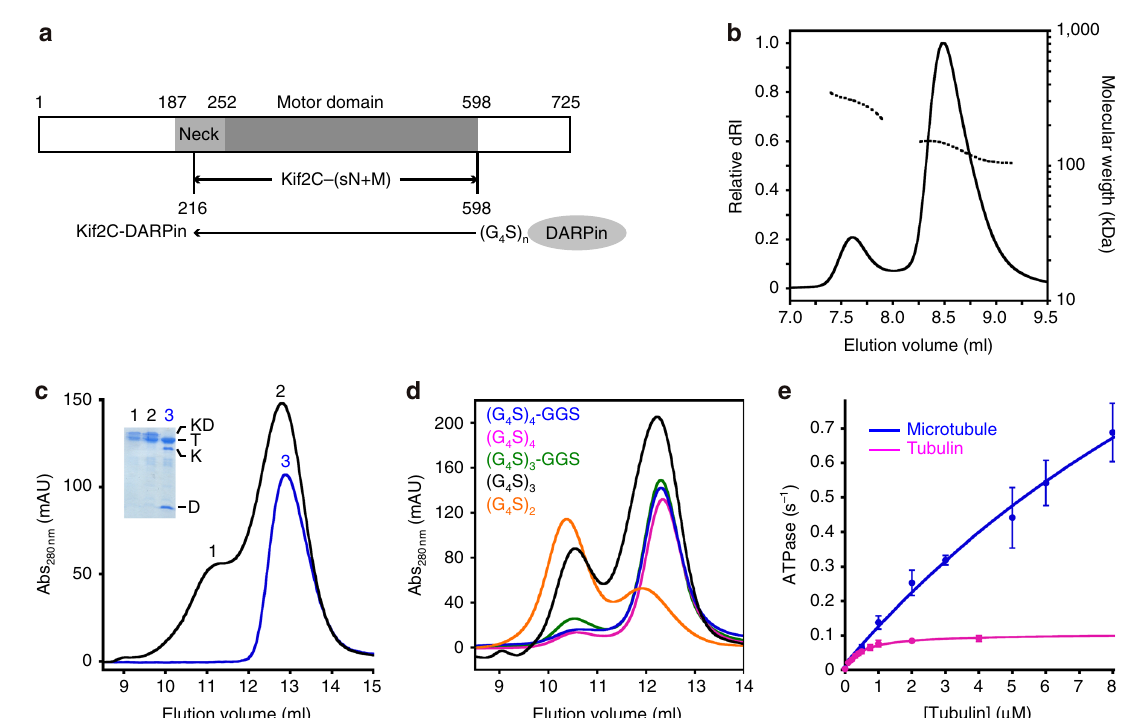
Fig. 1 Characterization of Kif2C-DARPin constructs. a Schematic presentation of Kif2C, of Kif2C-(sN+M), and of Kif2C-DARPin chimerical constructs. b SEC-MALLS analysis of tubulin in complex with Kif2C-(sN+M) linked to the D1 DARPin by a (G 4 S) 3 peptide. The differential refractive index (normalized dRI, left axis ) and molecular mass ( right axis ) are plotted as a function of the column elution volume. The derived masses from the static light-scattering data are about 307 kDa for the fi rst peak (elution volume between 7.43 and 7.75 ml) and 153 kDa for the second peak (elution volume 8.2 – 8.4 ml). These masses reasonably match those calculated from tubulin:construct complexes of stoichiometry 2:2 (about 320 kDa) and 1:1 (about 160 kDa). The pro fi le of the second peak and the mass estimate of its tail (about 110 kDa, elution volume 8.9 to 9.09 ml) are consistent with some dissociation of the complex in the column. Values of the molar mass moments of the peaks are given in Supplementary Table 2. c Gel fi ltration chromatograms of tubulin mixed with a covalent Kif2C-(sN+M)-(G 4 S) 3 -DARPin construct ( black curve ) or with isolated Kif2C-(sN+M) and DARPin proteins ( blue ). For this experiment, 75